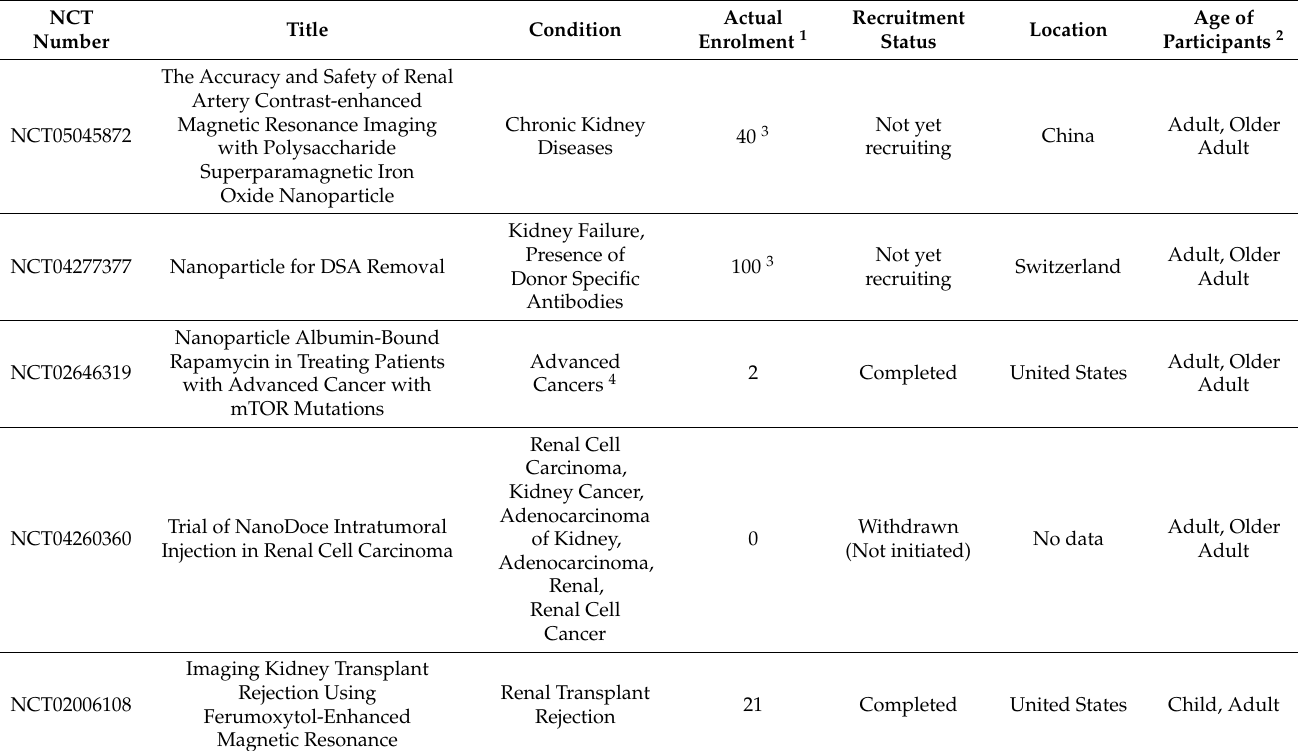
Table 1. Clinical trials concerning nanoparticles in kidney diseases downloaded from the ClinicalTria ls.gov database (https://clinicaltrials.gov/, accessed on 30 September